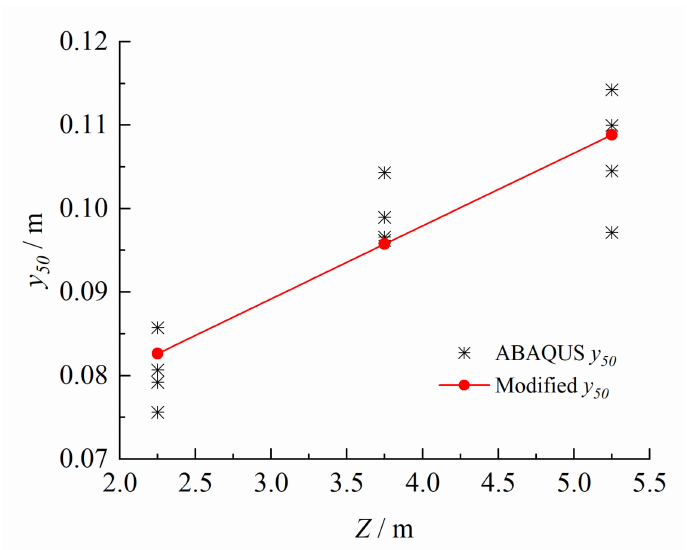
Figure 17. Modified displacement of the